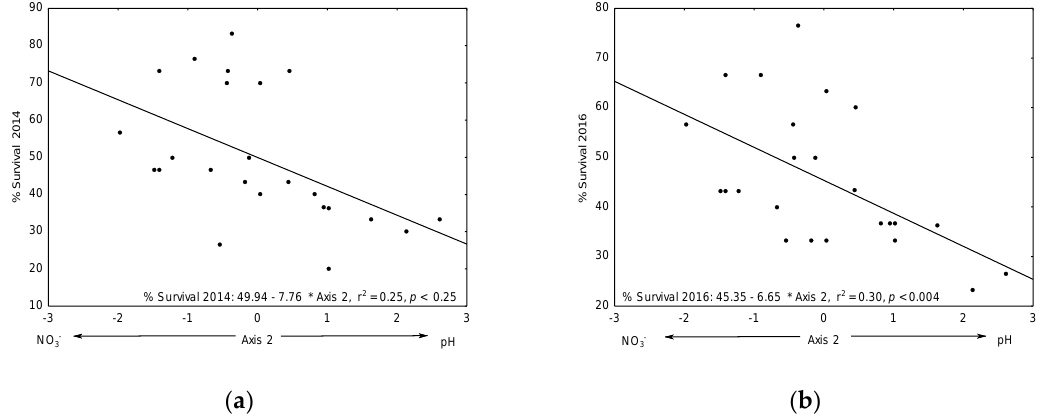
Figure 5. Regression of survival as a function of PCA scores of soil properties in 2014 (a) for survival in 2014 and (b) survival in 2016 for all tree species irrespective of growth rank. Value of r 2 , regression line, and equation are shown.